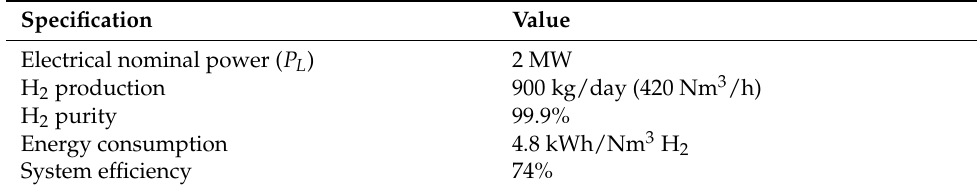
Table 8. Specifications of a 2 MW H-TEC PEM system [40].